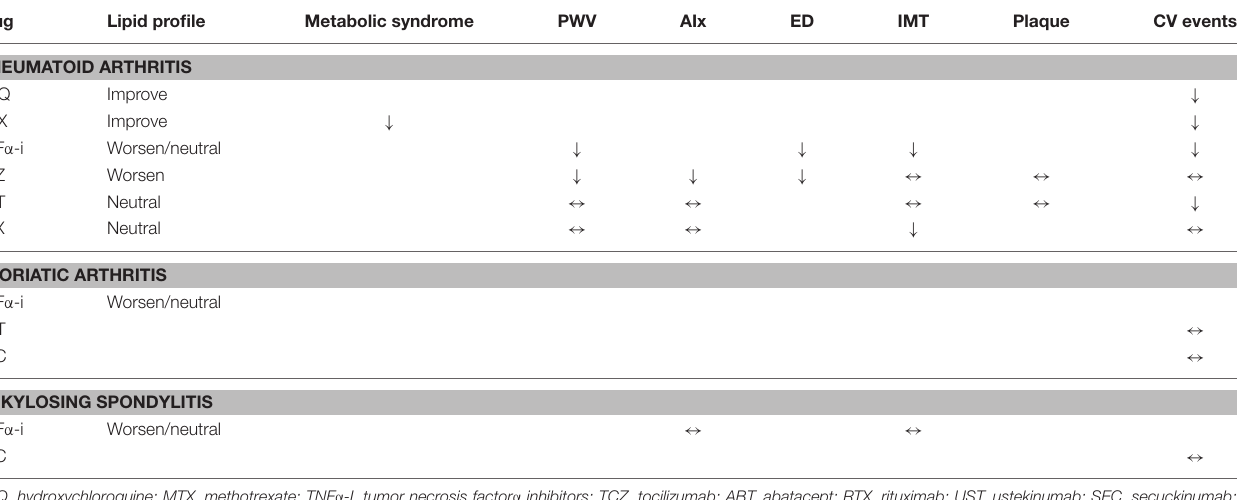
TABLE 1 | Effect of non-biologic and biologic drugs on CV risk in RD patients. Drug Lipid